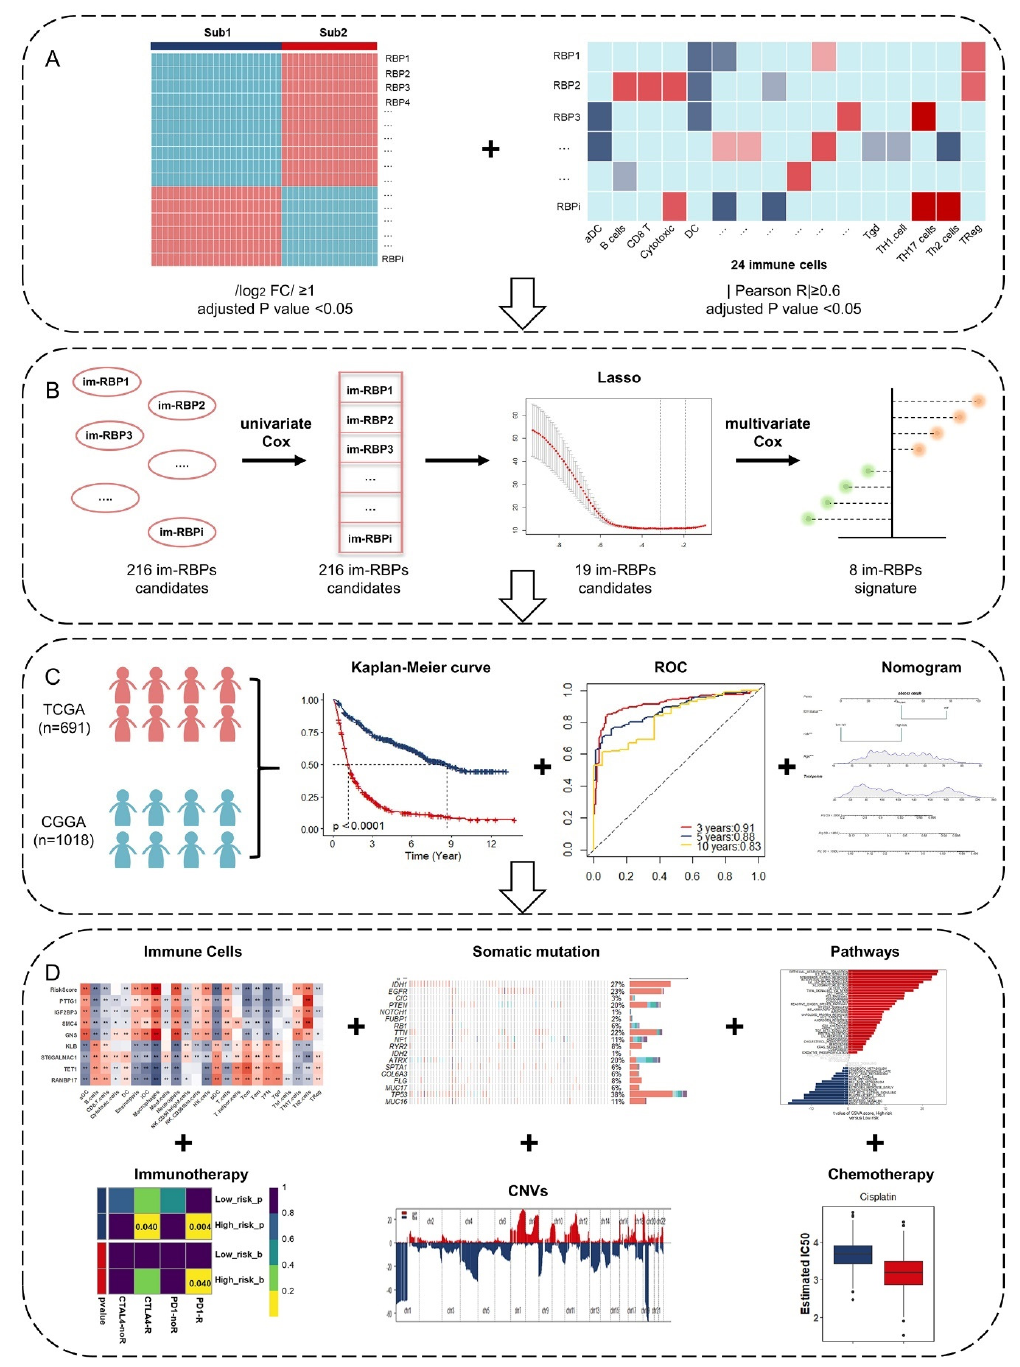
Figure 1. Schematic workflow for analyzing immune-associated RBPs in glioma: ( A ) Two immune subtypes identified by ssGSEA and “ConsensusClusterPlus” package, and the differentially expressed RBPs singled out by “limma” package between two subtype groups. Correlation analysis between differentially expressed RBPs and immune cells. ( B ) A combination of the LASSO and Cox regression analysis to identify a prognostic signature based on immune-associated RBPs (im-RBPs: immune-associated RBPs). ( C ) Identification and assessment of the prognostic signature of immune-associated RBPs for overall survival of glioma patients in TCGA and CGGA. ( D ) Comprehensive analyses of tumor-infiltrating immune cells, responses to immunotherapy, somatic mutations, copy number variations, enriched pathways, and responses to chemotherapy. *, p < 0.05; **, p < 0.01;***, p <